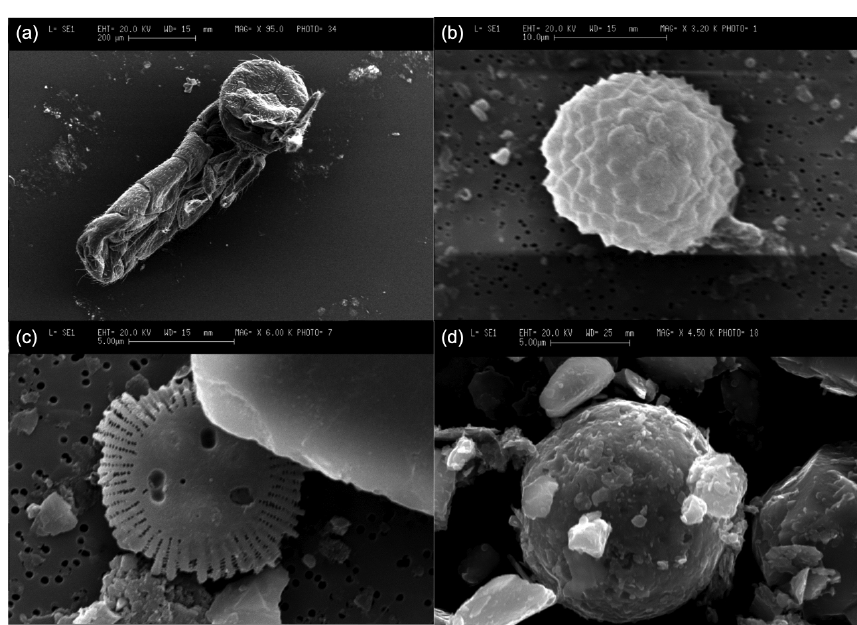
Figure 7. SEM investigation on bulk samples from Forni Glacier evidenced the presence of (a) organisms of collembolan order, (b) spores, (c) diatoms and (d) cenospheres (a residual product of carbon